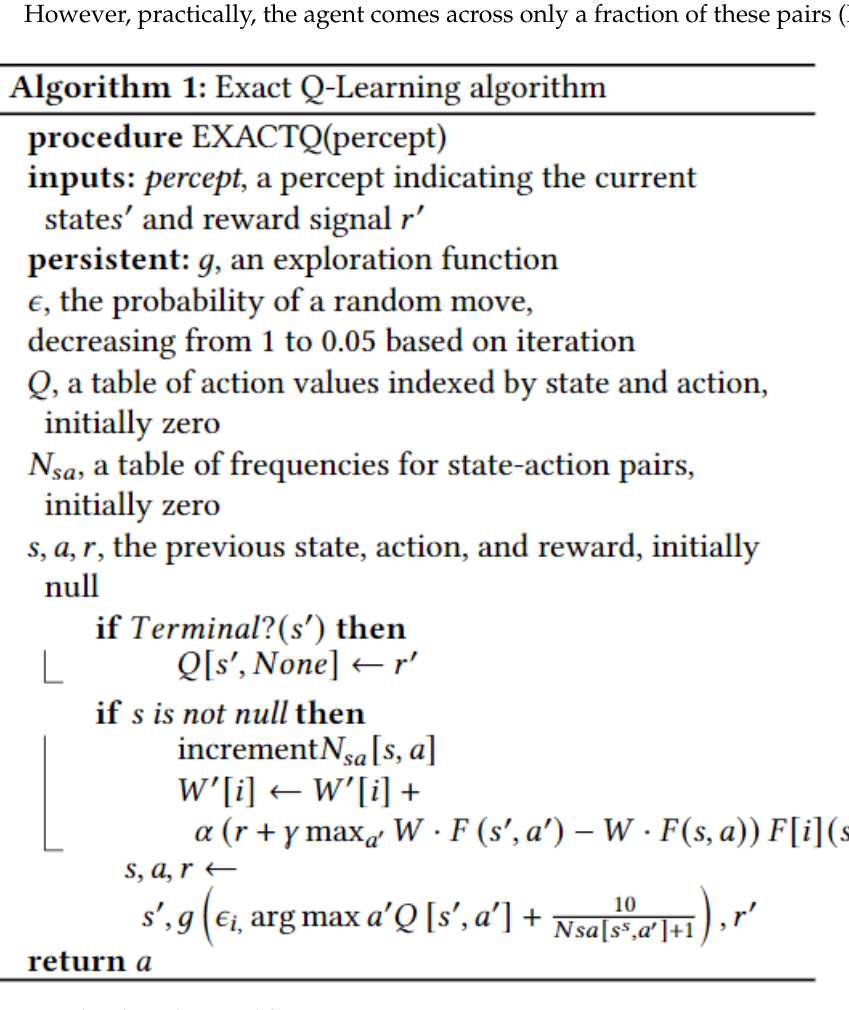
Figure 7. The algorithm used for Exact Q